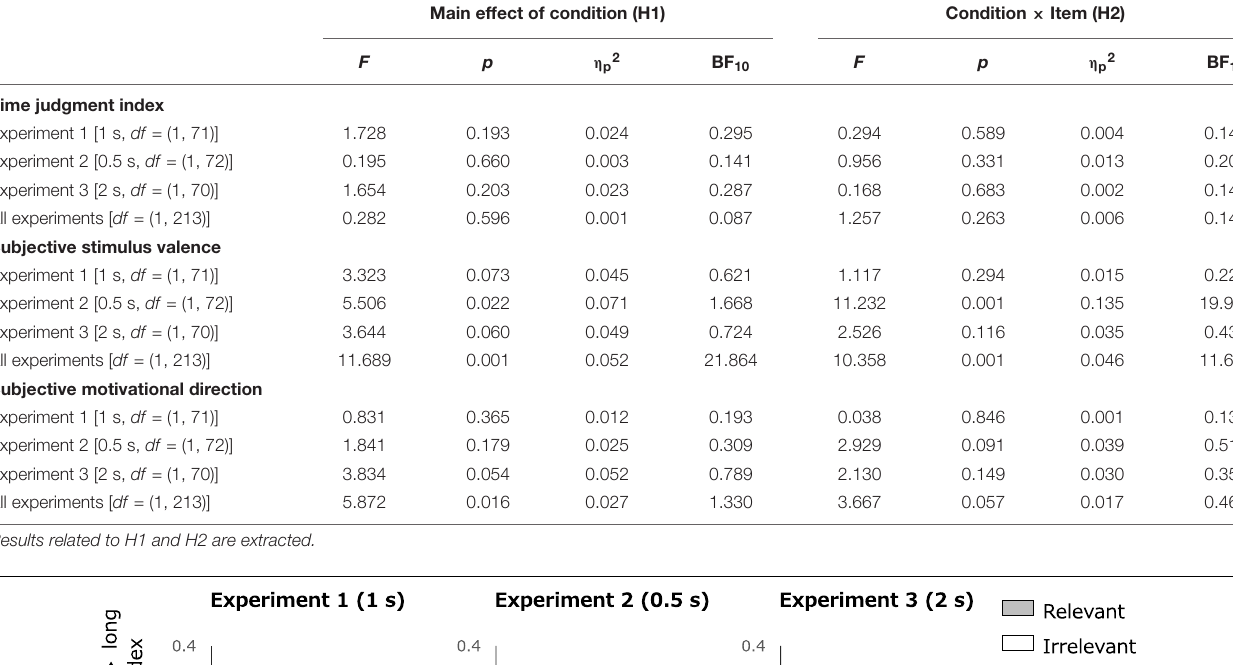
TABLE 1 | Results of the Condition × Item ANOVA in each experiment and Duration × Condition × Item ANOVA across all experiments. Main effect of condition (H1)